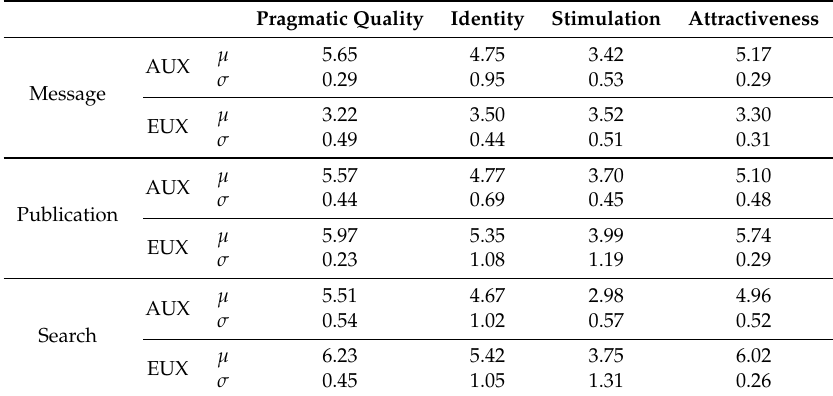
Table 3. AttrakDiff dimensions